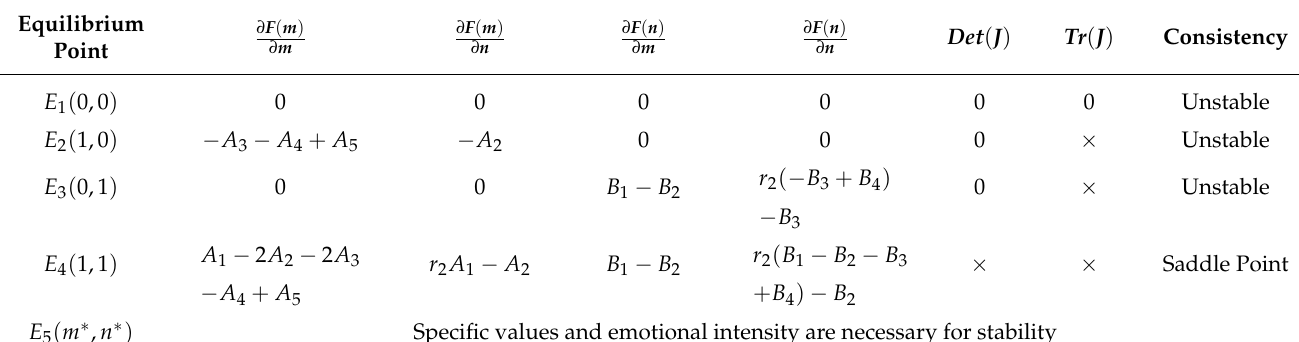
Table 5. Stability examination of strategy portfolios under scenarios with rational government regulators and optimistic energy